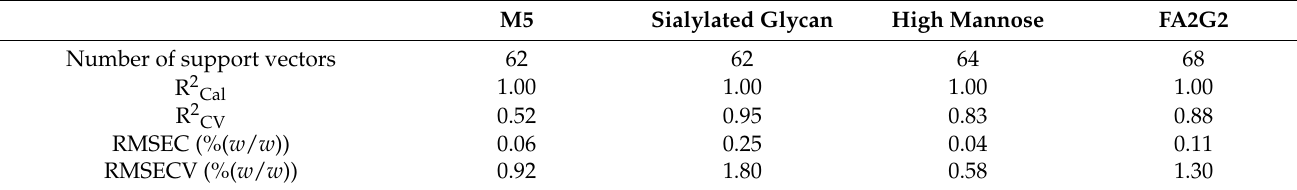
Figure 10. Measured versus predicted amounts of monosaccharides obtained by SVR regression between 800 and 1150 cm − 1 for the analysis of the amount of each glycan at low concentration (3 mg mL − 1 ) of mAbs. Table 4. Performances of SVR models in predicting glycan at low